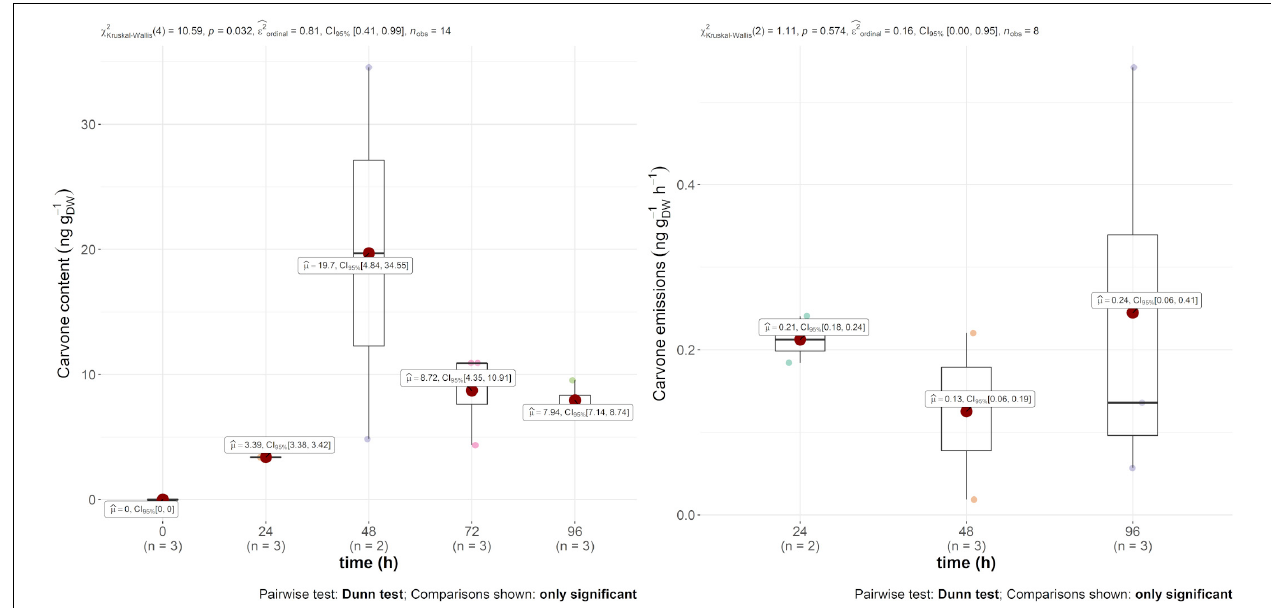
FIGURE 2 | Boxplot of D-carvone contained (in ng g DW − 1 ) in the leaves (left) and in the emissions (ng g DW − 1 h − 1 ) (right) over time after injection.